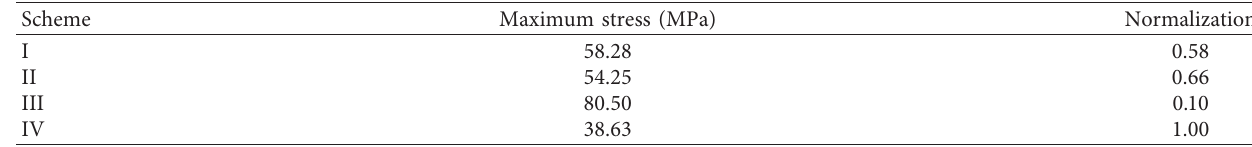
Figure 8: The stress changes at the monitoring points of the roof fillings of the four schemes. (a) Scheme (I) (b) Scheme II. (c) Scheme III. (d) Scheme IV. Table 2: Comparison of the unloading capacity of four schemes.